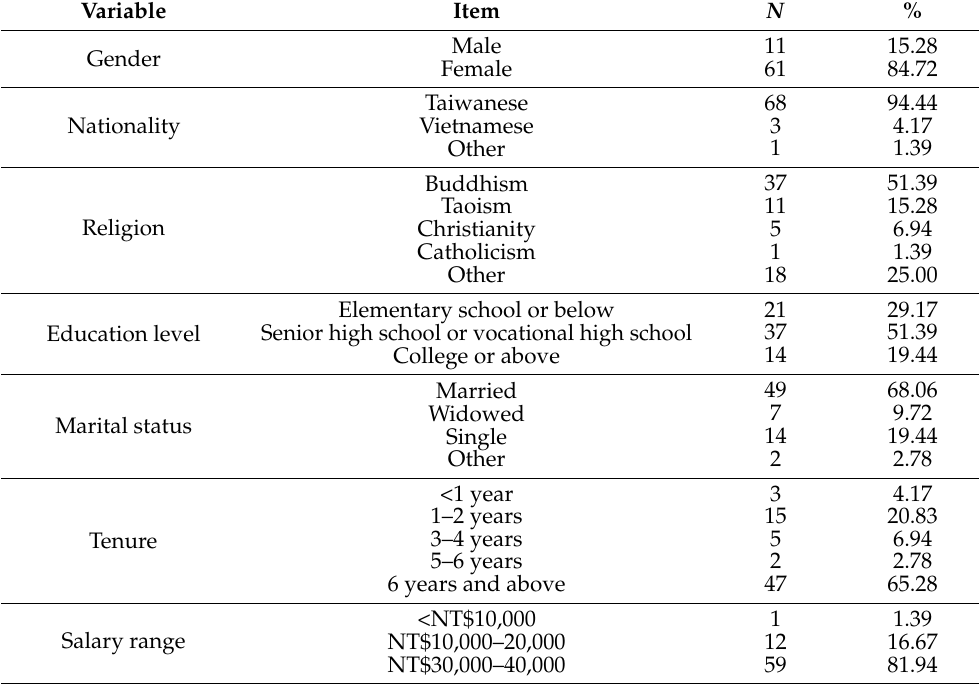
Table 1. Demographic variables of nurse aides ( N =